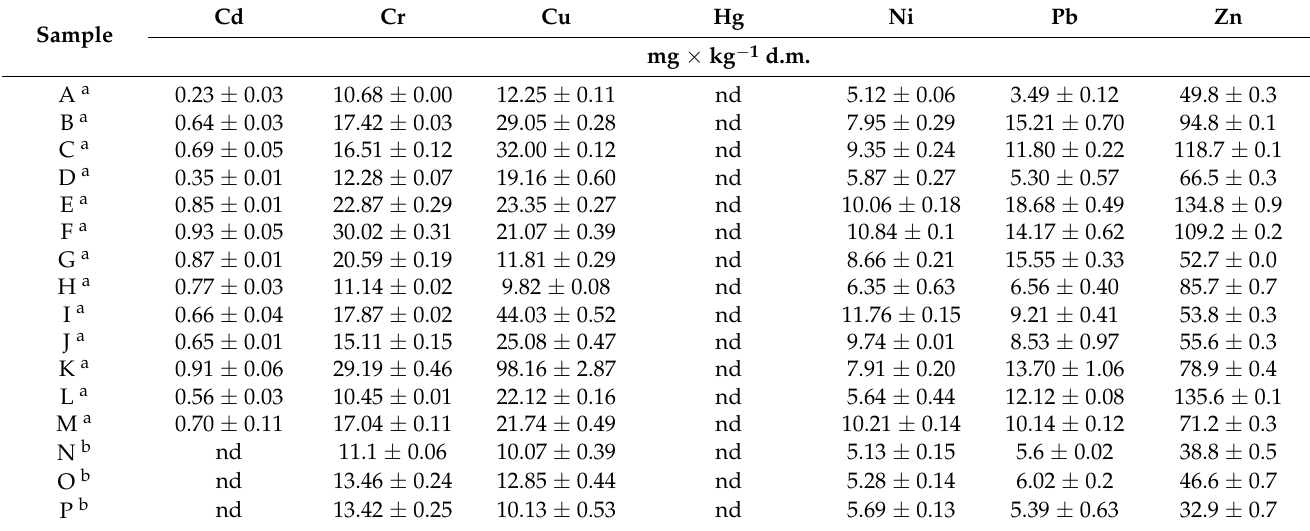
Table 2. The determined potentially toxic element content of the examined